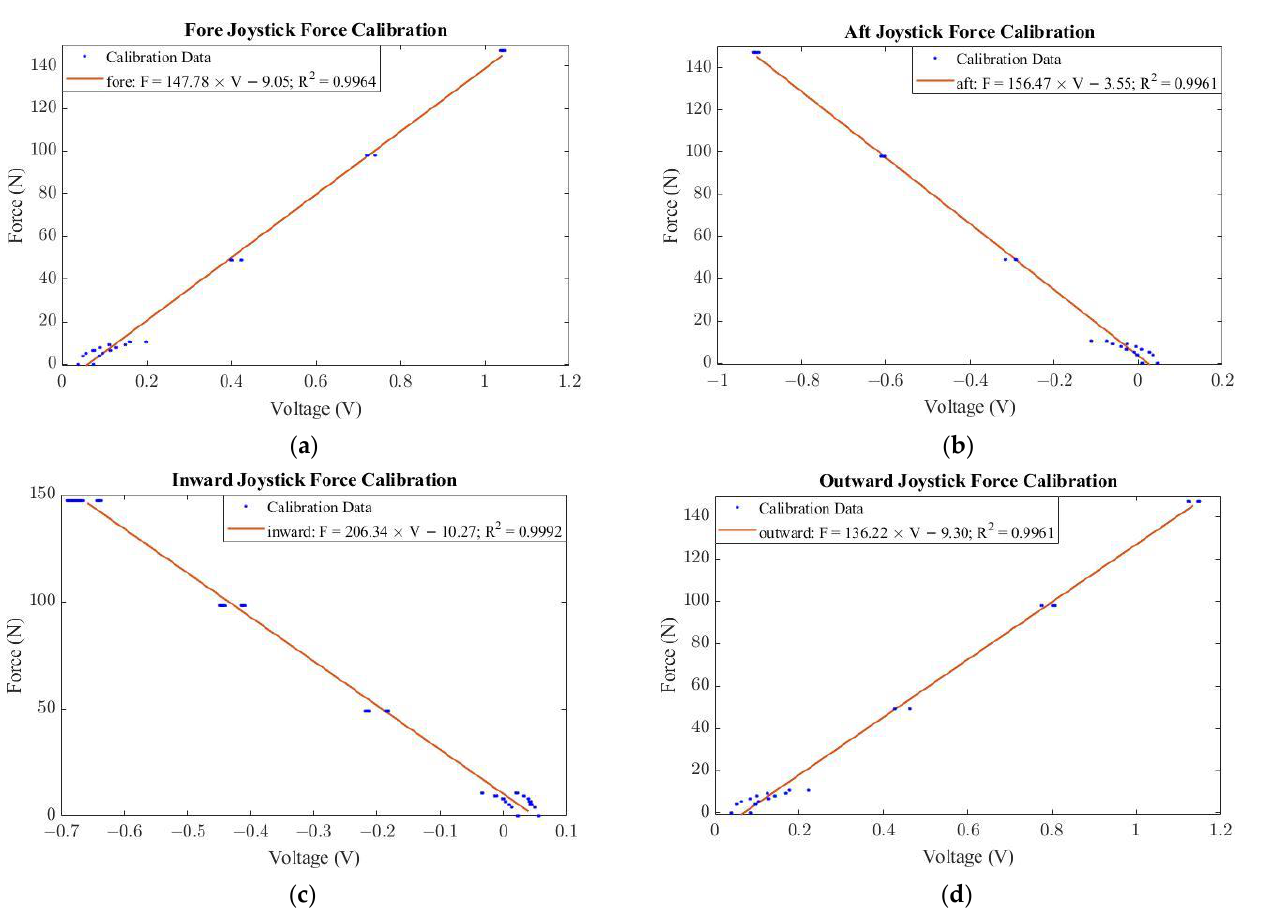
Figure 2. Horizontally dynamic armrest (DA) [28] mounted on top of fore – aft dynamic armrest [26,27]. Top figures — front views; bottom figure — side view.